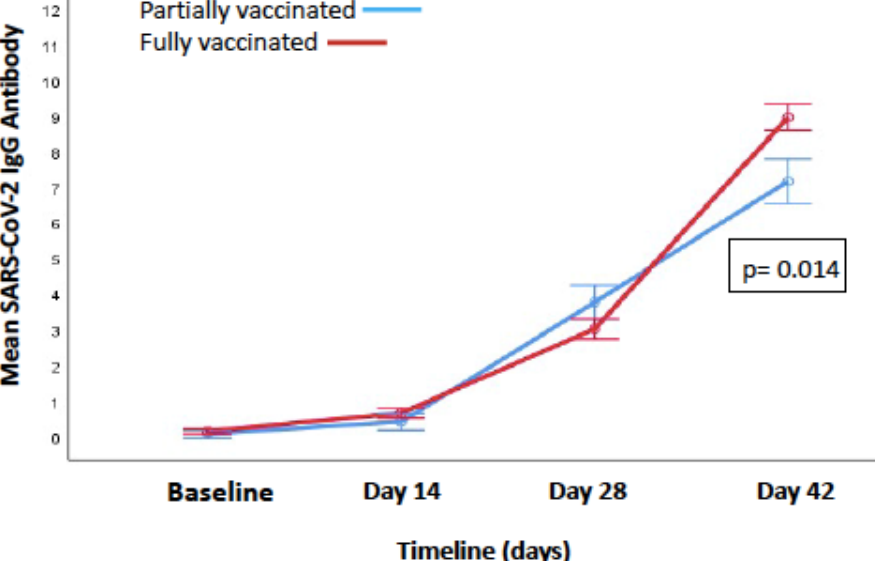
Figure 1. Difference in the SARS-CoV-2 IgG antibody levels from baseline to day 42 in partially and fully vaccinated HCWs.